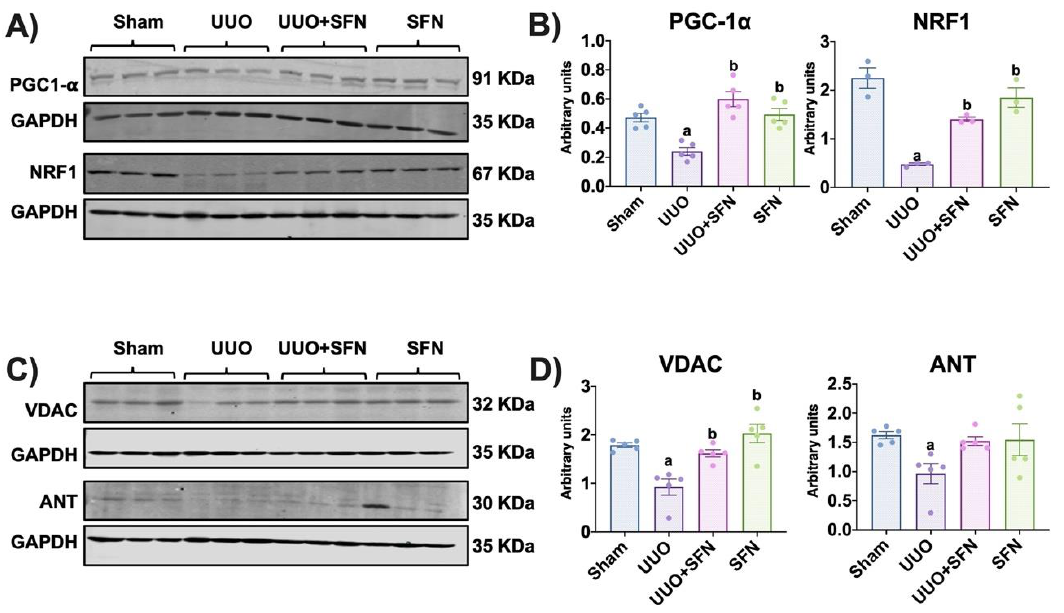
Figure 3. Sulforaphane (SFN) induces mitochondrial biogenesis and mitochondrial mass increase in the unilateral ureteral obstruction (UUO) model. ( A ) Representative immunoblotting and ( B ) densitometric analysis of mitochondrial biogenesis markers peroxisome proliferator-activated receptor- γ coactivator (PGC)-1 α (PGC-1 α ) and nuclear respiratory factor 1 (NRF1). n = 5 per group for PGC-1 α and n = 3 per group for NRF1. ( C ) Representative immunoblotting and ( D ) densitometric analysis of mitochondrial mass markers voltage-dependent anion channel (VDAC) and adenine nucleotide translocator (ANT), n = 5 per group. Data were analyzed using a one-way ANOVA, and statistical differences were determined with multiple comparisons using Tukey’s test. Glyceraldehyde 3-phosphate dehydrogenase (GAPDH) was used as a loading control. a p < 0.05 vs. Sham, b p < 0.05 vs. UUO. Sham: simulated surgery without ligation of the ureter; UUO: unilateral ureteral obstruction with double ligation of the left ureter for seven days; UUO + SFN: UUO treated with SFN (1 mg/kg, intraperitoneal); and SFN: administered with SFN (1 mg/kg, intraperitoneal).